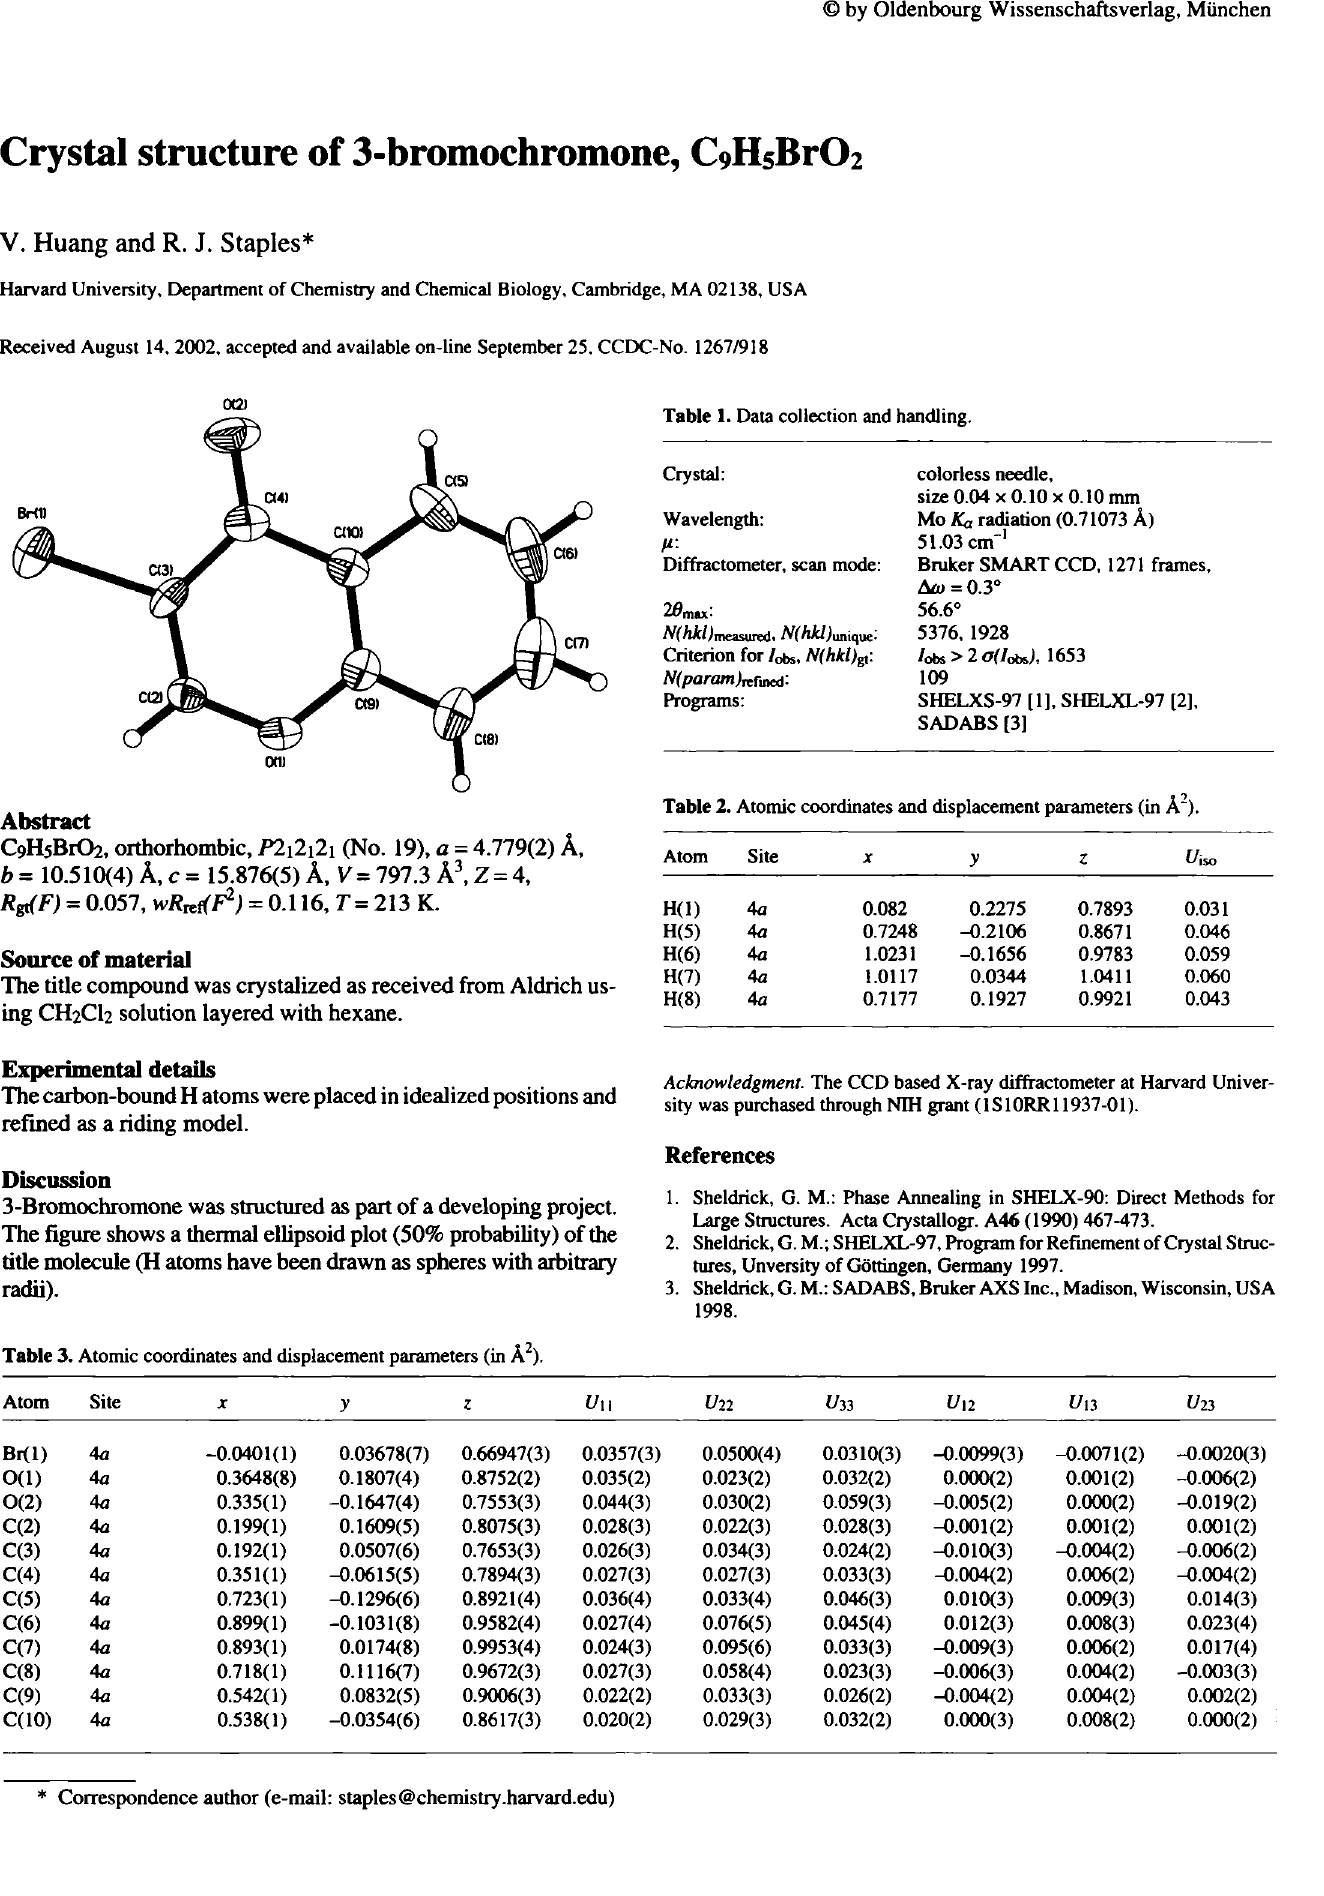
Table 1. Data collection and handling.